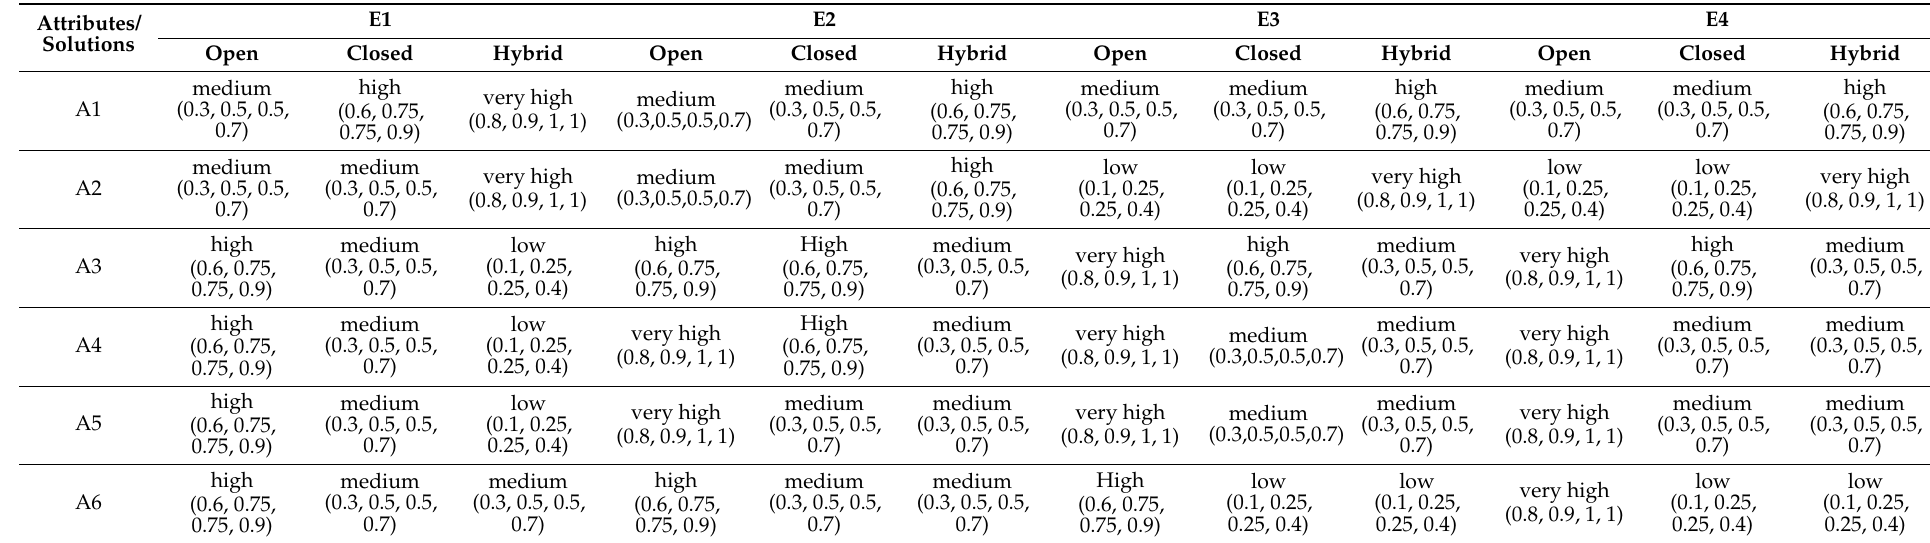
Table 8. Technical survey